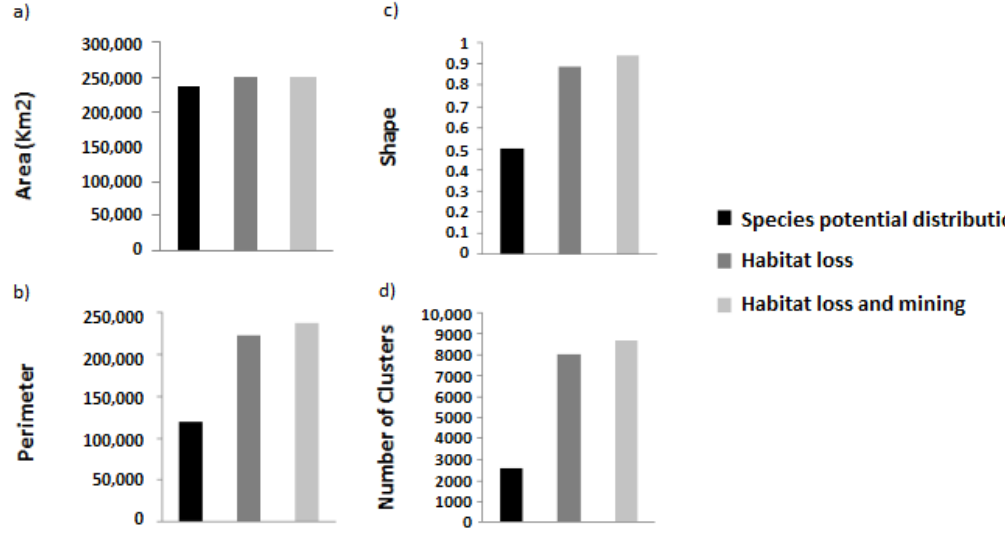
Figure 3. Area and configuration of the conservation area network (area, perimeter, shape, and number of clusters or fragments) including 20% of the 179 species potential distribution, species extant distribution due to habitat loss, and species extant distributions due to habitat loss and mining activities, respectively.